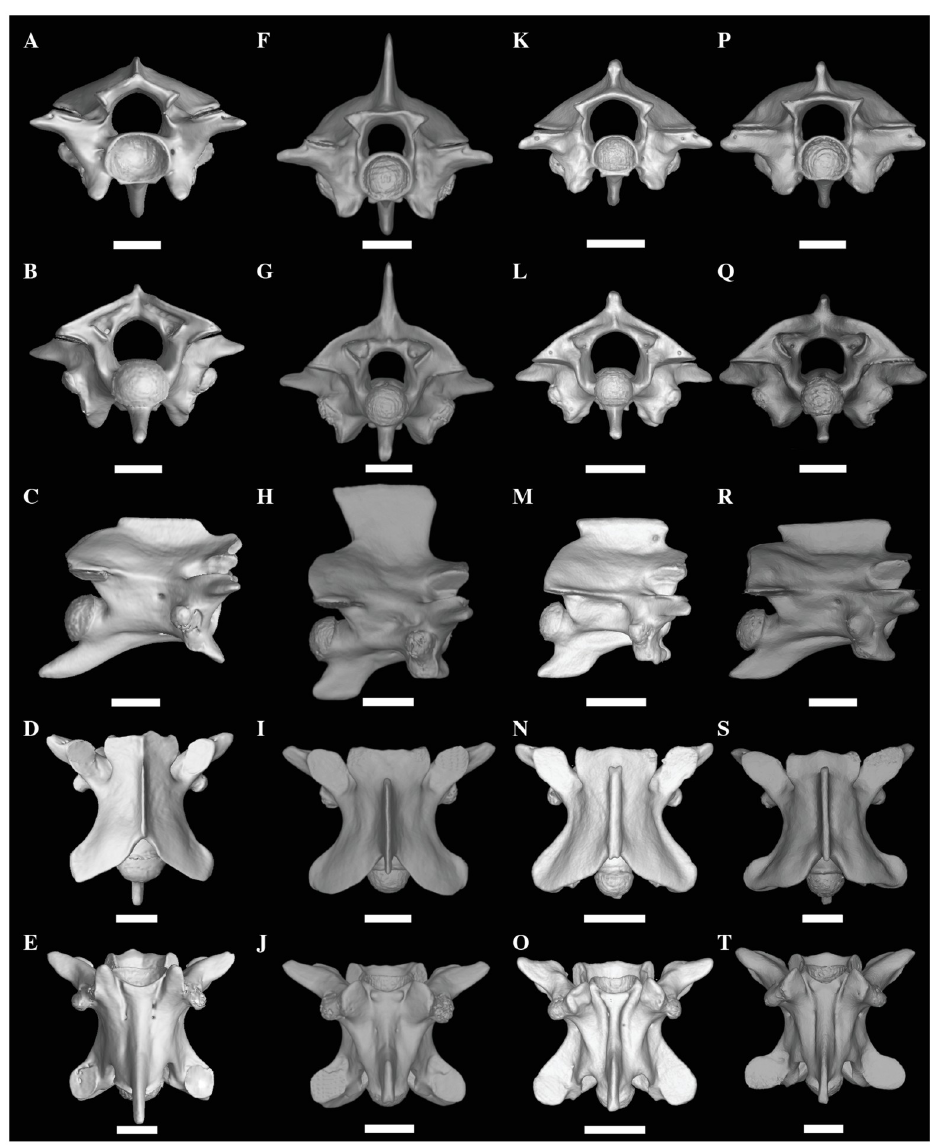
Fig 27. Mid- to posterior trunk vertebrae of Causus difilippi (A-E), Cerberus rynchops (F-J), Cyclocorus lineatus (K-O), and Sinomicrurus macclellandi (P-T). Three-dimensional surface and cutaway views based on high resolution X-ray computed tomography. A, F, K, P, anterior views; B, G, L, Q, posterior views; C, H, M, R, right lateral views; D, I, N, S, dorsal views; E, J, O, T ventral views. A-E, scale bar = 5 mm; F-J, scale bar = 2mm; K-O, scale bar = 1mm; P-T, scale bar =